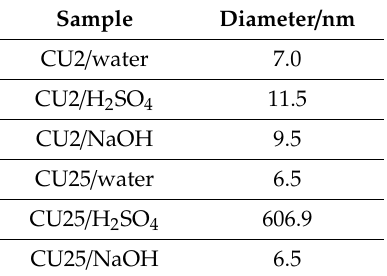
Table 1. The hydrodynamic radius of CU2 and CU25 C-dots in the three aqueous solutions at different pH.